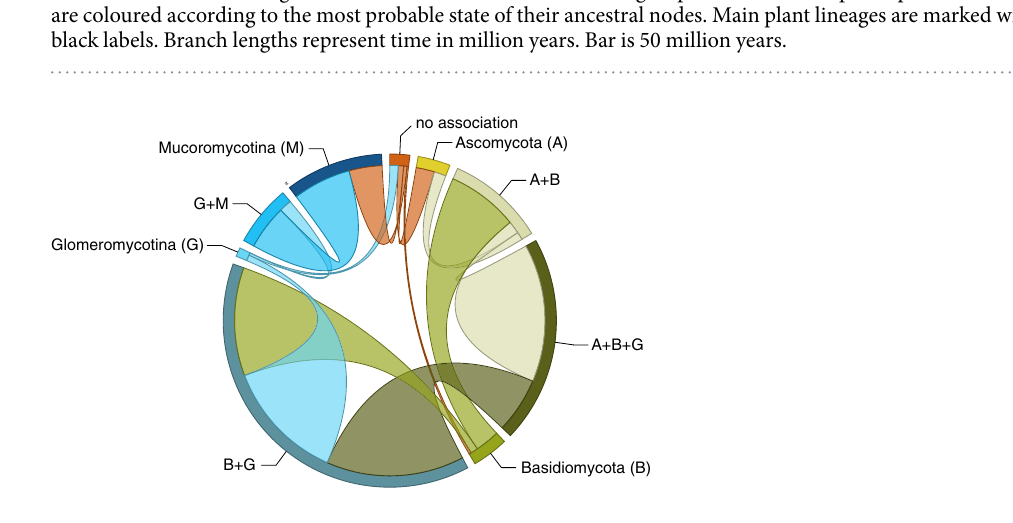
Figure 2. Transitions of mycorrhiza-like associations in land plant evolution. Frequency of transitions between different repertoires of mycorrhiza-like association as optimised on our phylogeny (Fig. 1). The band size for each state (labelled next to the bands) represents the number of transitions from that state proportional to the total number of reconstructed transitions; and the width of the ribbons is proportional to the numbers of transitions starting from that